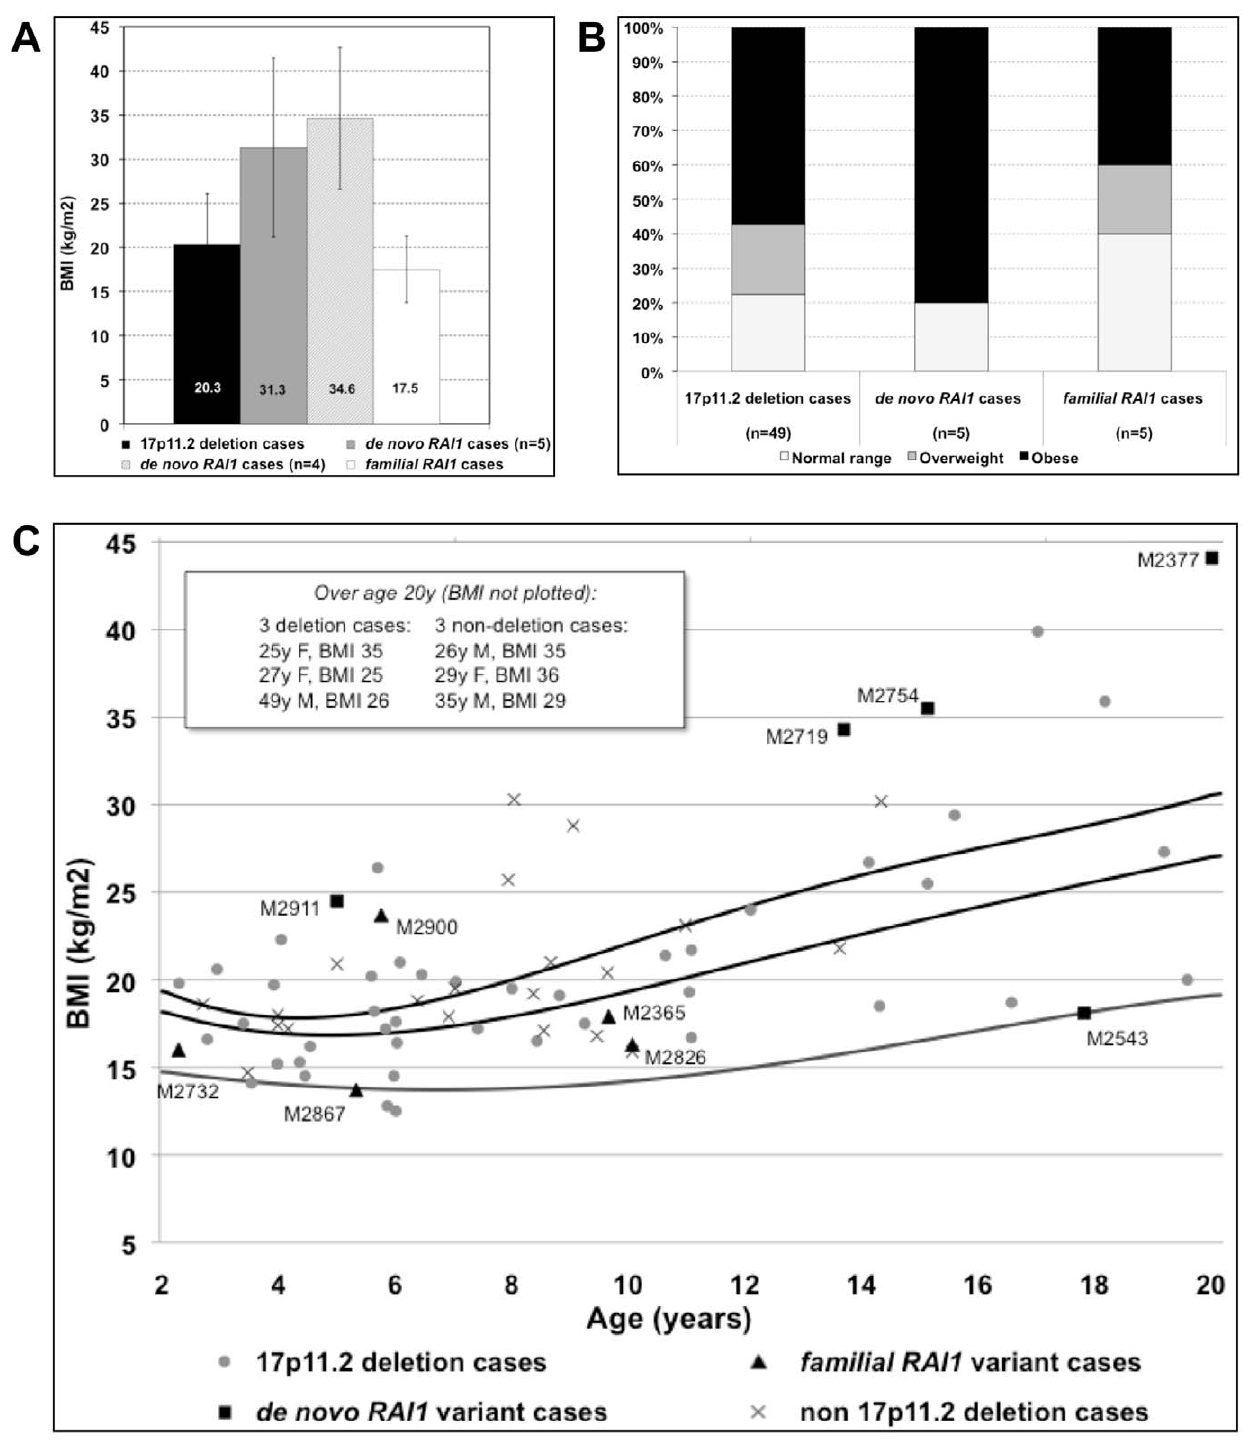
Figure 4. Body mass index (BMI) analysis of SMS patients. Comparison of BMI (kg/m2) for common 17p11.2 deletion cases (n=49), and cases with de novo (n=5, including unclassified variant M2543) or familial (n=5) RAI1 variants. (A) The mean BMI for each subgroup. The value for the de novo RAI1 group was calculated with and without the outlier unclassified case (M2543) who carried an RAI1 missense variant. (B) Frequency of body description type ( normal , overweight , or obese ) based on BMI values considering age (as plotted in (C)) and gender. Interpretation of BMI levels for age 2–20 years: underweight, , 5 th percentile; normal range, 5 th –85 th percentile; overweight, 85 th –95 th percentile; and obese, . 95 th percentile. For adults: underweight, BMI below 18.5; normal range, BMI 18.5–24.9; overweight, BMI 25–29.9; and obese, BMI 30 and over. (C) Comparison of BMI by age for subjects 2–20 years of age. BMI percentile curves (5 th , 85 th and 95 th ) for ages 2–20 years were extracted from growth data from the Centers for Disease Control and Prevention. BMI values are not plotted for 6 subjects over age 20 years; 3 with common deletions and 3 without deletions or RAI1 mutations (their values are displayed in upper left of the figure).